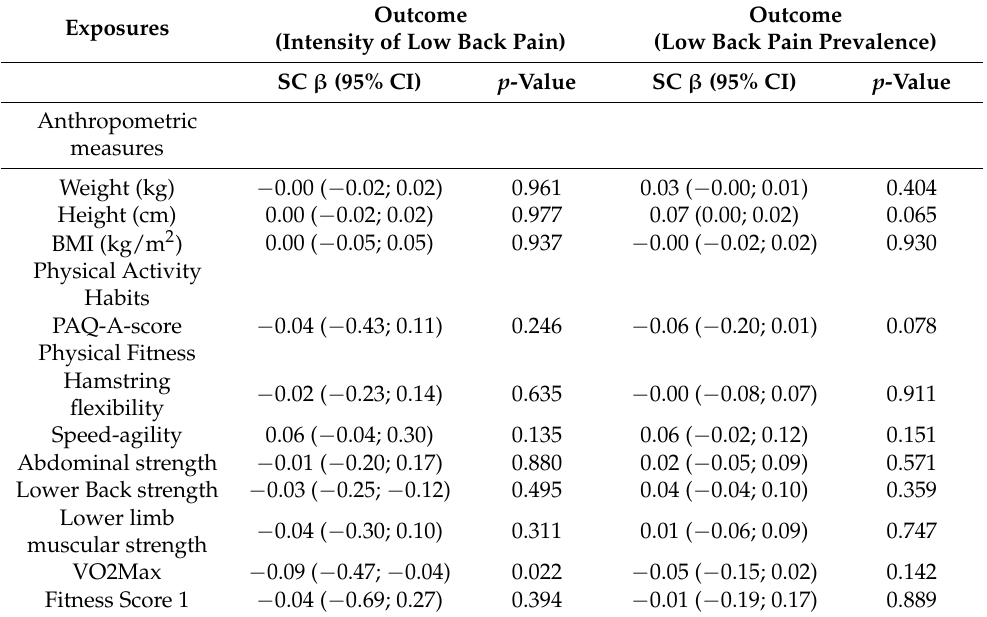
Table 2. Associations of physical fitness with low back pain.